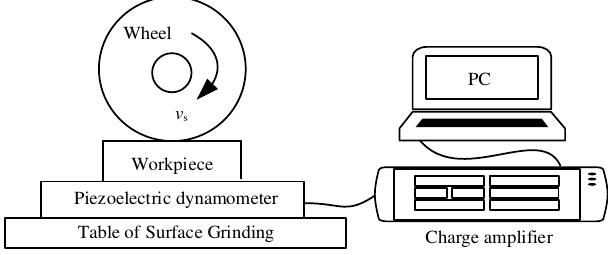
Figure 2. Illustration of experimental setup for grinding.